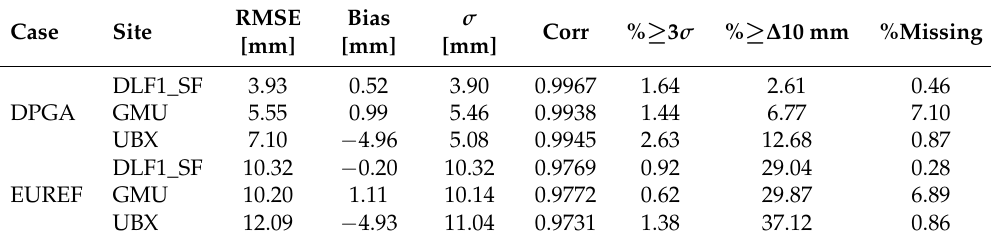
Table 3. Statistics on the experimental setup data using dual-frequency ZTD estimations as reference. Units of the RMSE, bias, and standard deviation ( σ ) are depicted in